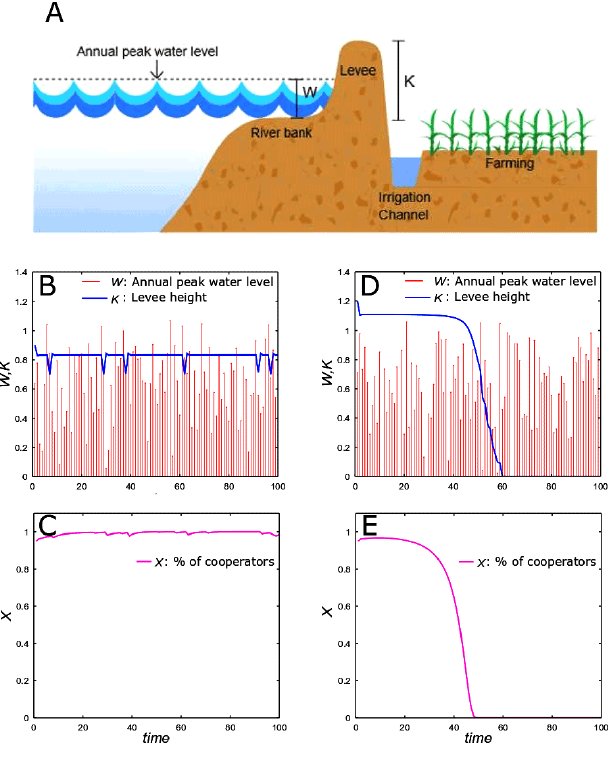
Fig. 4 . (a) A conceptual cross-section view of polders. (b-c) A scenario of moderate flood protection level and “living with floods” that allows opportunities for learning. The dynamics of three variables are traced over time under this scenario: peak water surge level (W), embankment height (K), and percentage of cooperators (X). This scenario shows that allowing moderate exposure to flooding can help maintain the community norm for collective action through continuous social learning. (d-e) A scenario of high flood protection level. The dynamics of W, K, and X under this scenario show that the suppression of hydrological variability and the lost opportunities for social learning can cause the community norm to decay and eventually collapse. Adapted from Yu et al.